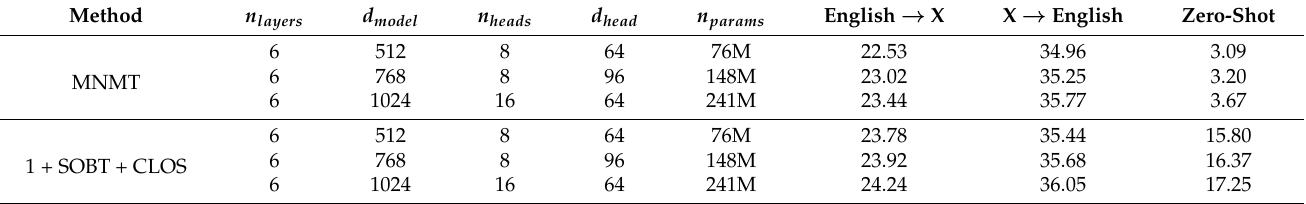
Table 6. Performance (BLEU) on the OPUS-100 dataset. We thoroughly evaluate our methods with different model